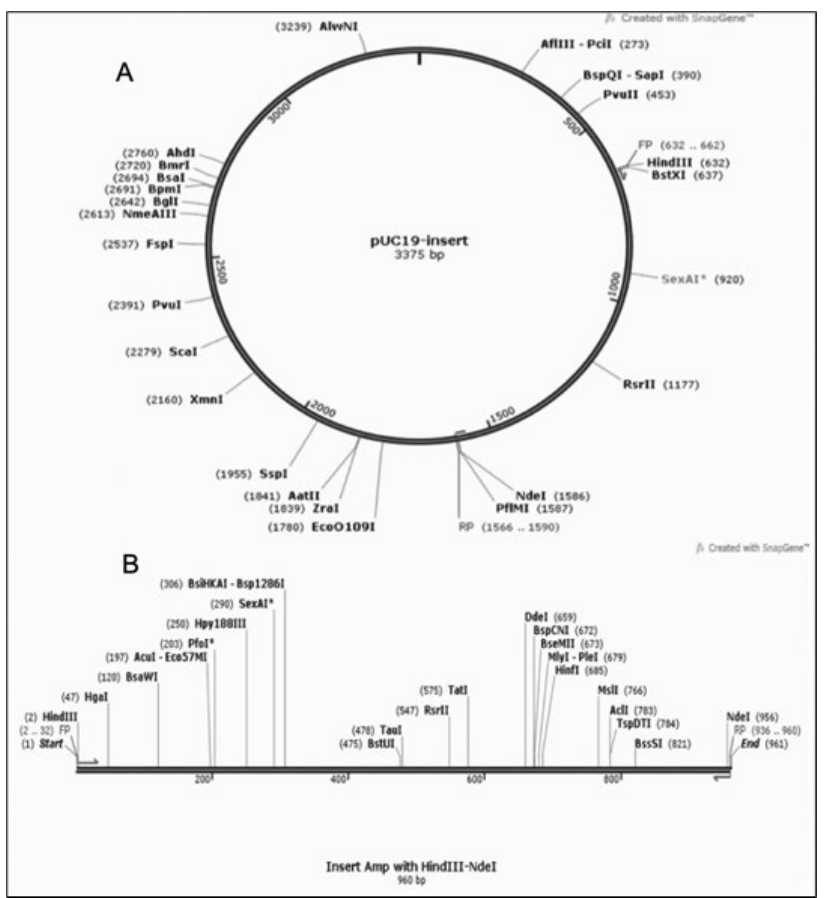
Fig. 13. (A) gene insert in PUC19 vector (B) Insert map with gene of interest in between HindIII and NdeI restriction